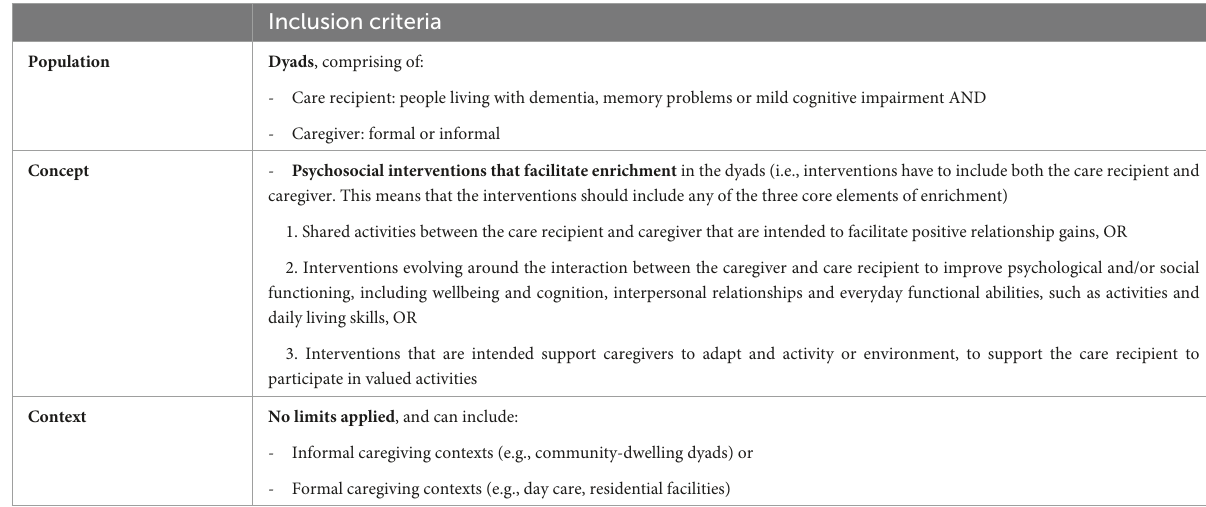
TABLE 2 Population, concept, context (PPC)